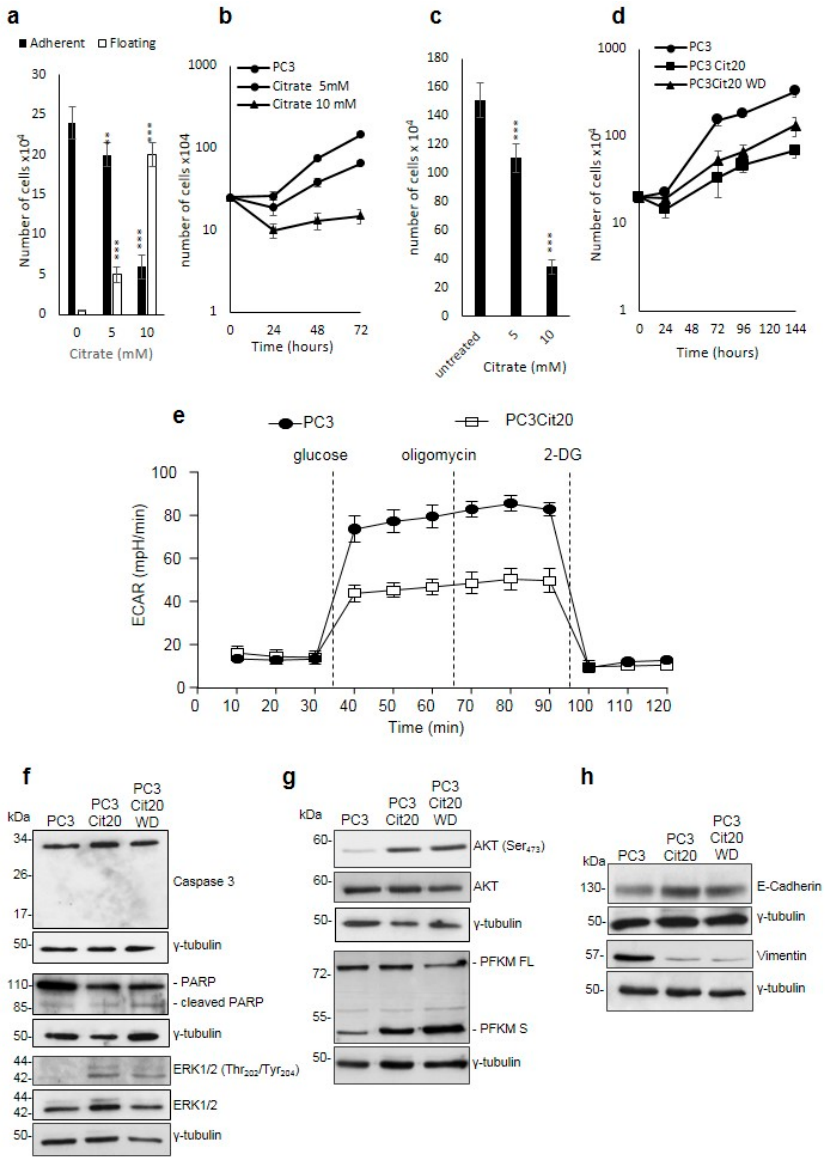
Figure 1. Citrate treatment affects PC3 cell proliferation, survival, and metabolism. ( a ) Citrate impairs the adhesion of PC3 cells in dose-dependent manner. ( b ) Citrate inhibits the proliferation in PC3 cells: 5 and 10 mM citrate was added to a culture medium of PC3 cells at the time of seeding, and cells were counted after 48 h in a Neubauer hemocytometer. Data are expressed as mean ± S.D. of a representative experiment performed in triplicate. The differences between treated and untreated cells are statistically significant ( p < 0.005 Anova followed by Bonferroni post -test). ( c ) PC3 cells were seeded, and citrate was added 24 h after plating. Cell number was determined after 72 h. Data represent the mean of quadruplicate values of two independent dishes. ( d ) Growth curves of PC3 and PC3 Cit20 after citrate withdrawal. Cell number was determined at the indicated time points. Data represent the mean of quadruplicate values of two independent dishes ( p < 0.001 Anova followed by Bonferroni post -test). ( e ) Altered bioenergetic profile in citrate-resistant PC3 cells. Kinetic profile of ECAR in PC3 cells and PC3 cit20 (citrate-resistant) cells. Data are expressed as mean ± S.E.M. of three independent experiments, each of them in triplicate. ECAR was measured in real time, under basal conditions and in response to glucose, oligomycin, and 2-DG. ( f–h ) Lysates from PC3, PC3 Cit20, and PC3 Cit20 WD cells were analyzed by Western blot using the indicated antibodies. γ tubulin was used as loading control. * p ≤ 0.05; *** p ≤ 0.001, Student t -test.